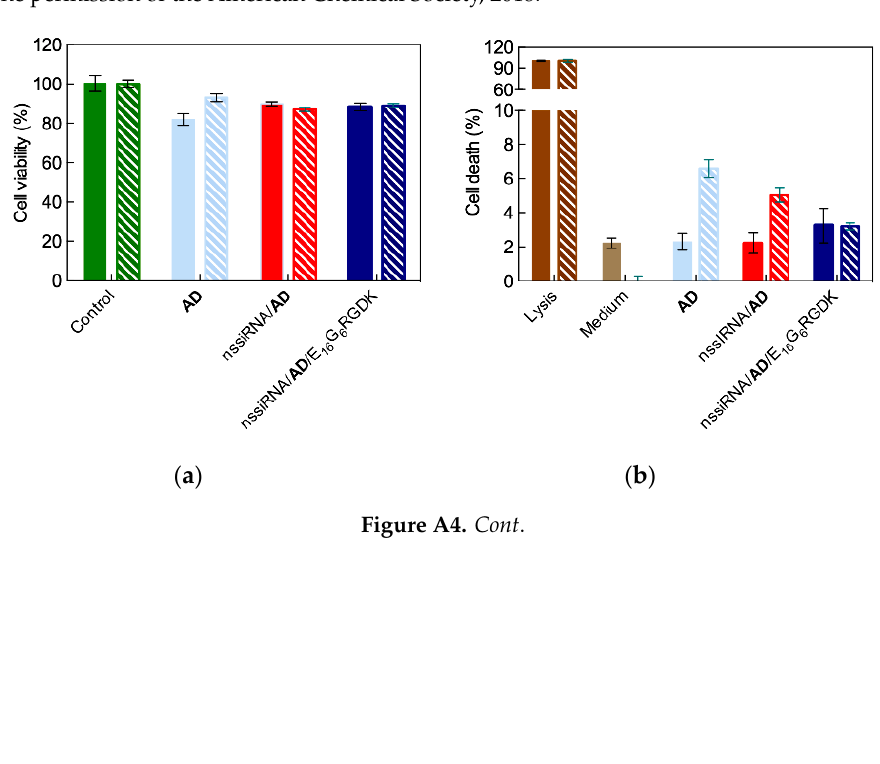
Figure A3. Confocal microscopy images of the successful endosomal escape of the siRNA/ AD /E 16 G 6 RGDK nanoparticles in PC-3 cells after incubation times 0 (control), 0.5, 1, and 2 h Red channel images show the cy5-labeled siRNA/AD/E 16 G 6 RGDK nanoparticles, the green channel images reveal the Lyso Tracker red-marked endosomes, and the blue channel images show the cell nuclei stained with Hoechst 33342. In all these experiments, the siRNA/ AD /E 16 G 6 RGDK nanoassemblies were prepared using 50 nM siRNA, siRNA/ AD N/P = 10, and AD /E 16 G 6 RGDK molar ratio = 5. Adapted from [8] with the permission of the American Chemical Society, 2018.